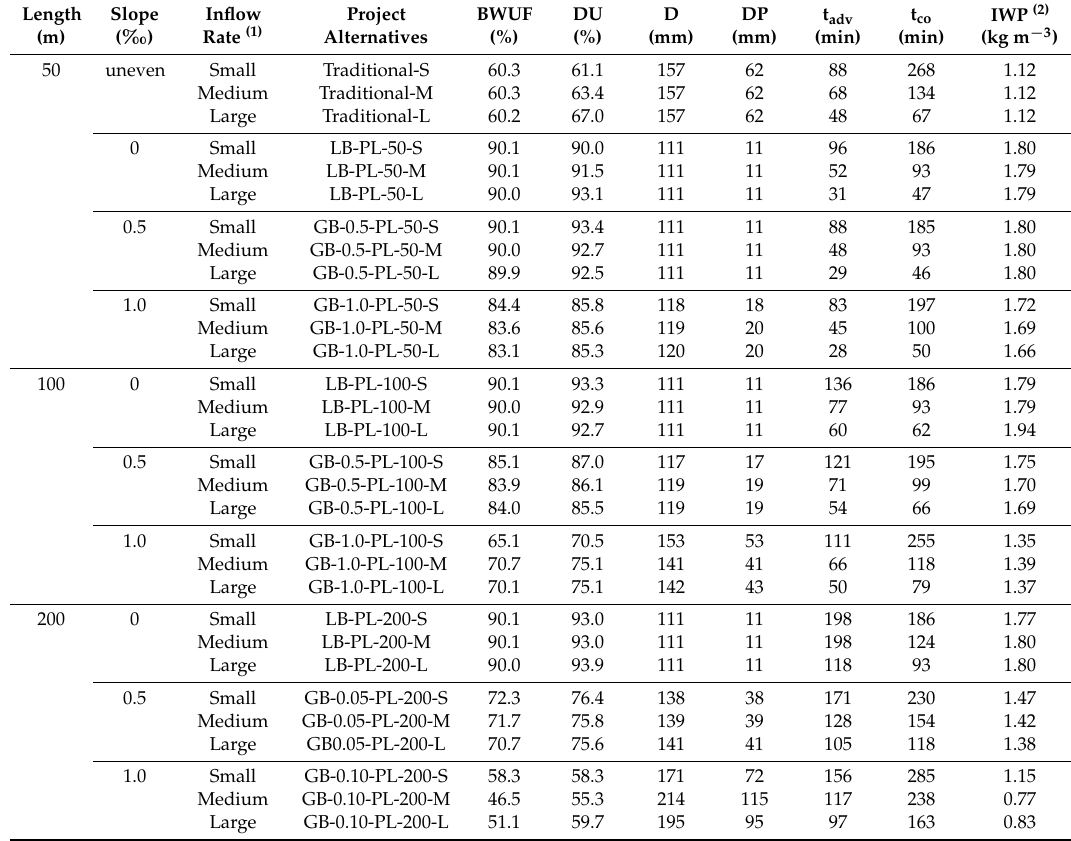
Table 9. Irrigation performance and management indicators for various basin lengths, longitudinal slopes, and unit inflow rates in the case of medium infiltration soils. Inflow Project Rate (1)